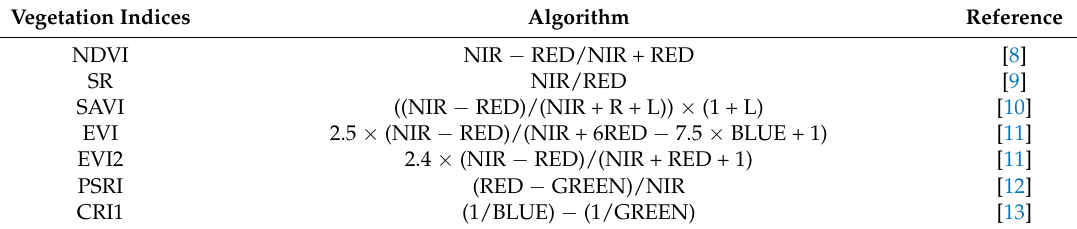
Table 2. Spectral vegetation indices used in LAI retrieval. Abbreviations: NDVI: normalized difference vegetation index; SR: simple ratio; SAVI: soil adjusted vegetation index; EVI: enhanced vegetation index; EVI2: enhanced vegetation index—improved; PSRI: plant senescence reflectance index; CRI1: carotenoid reflectance index 1; GVI: green vegetation index; GNDVI: green normalized difference vegetation index; GCI: green chlorophyll index; MSR: modified simple ratio; ARVI: atmospherically resistant vegetation index; MCARI: modified chlorophyll absorption ratio index; MTVI2: modified triangular vegetation